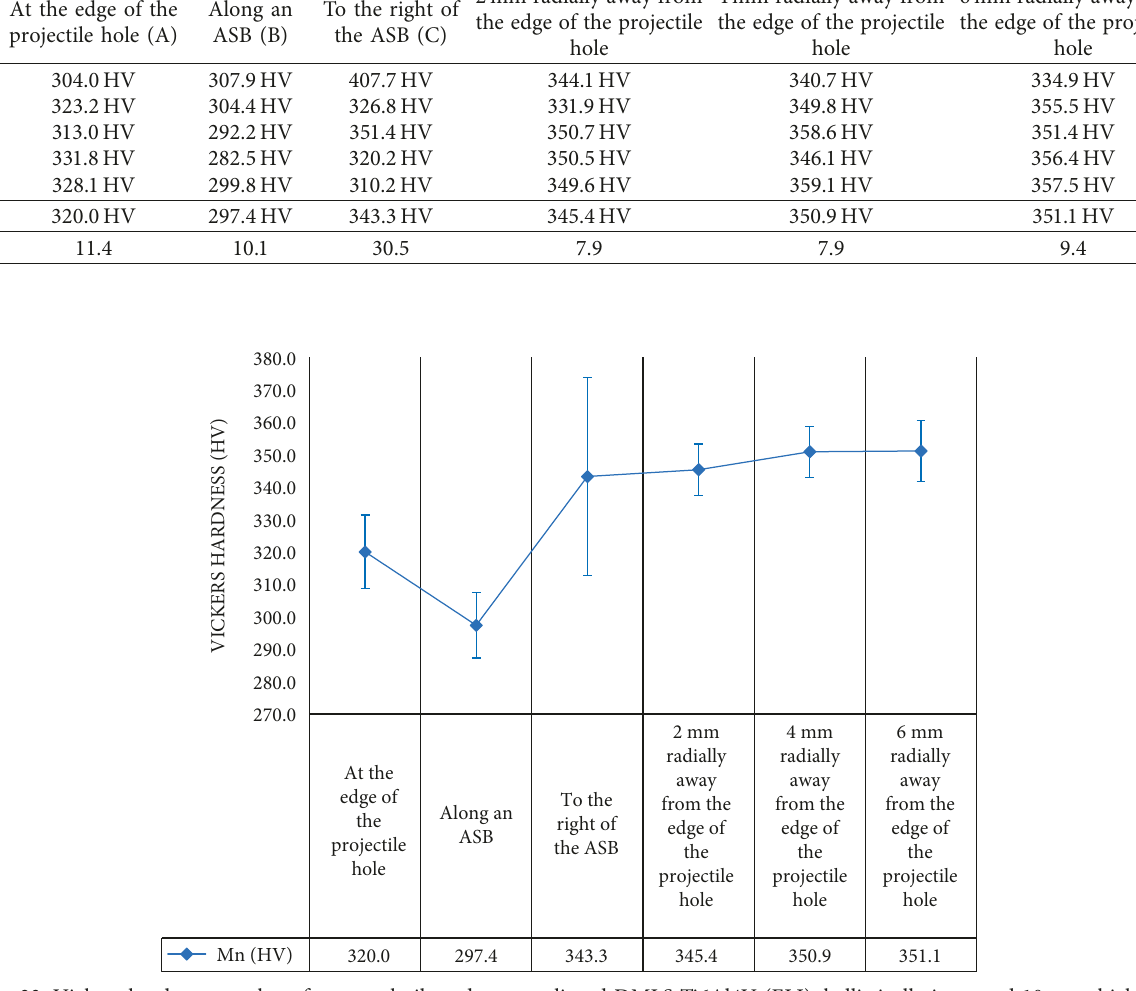
Figure 23: Vickers hardness numbers for an as-built and stress relieved DMLS Ti6Al4V (ELI), ballistically impacted 10mm thick